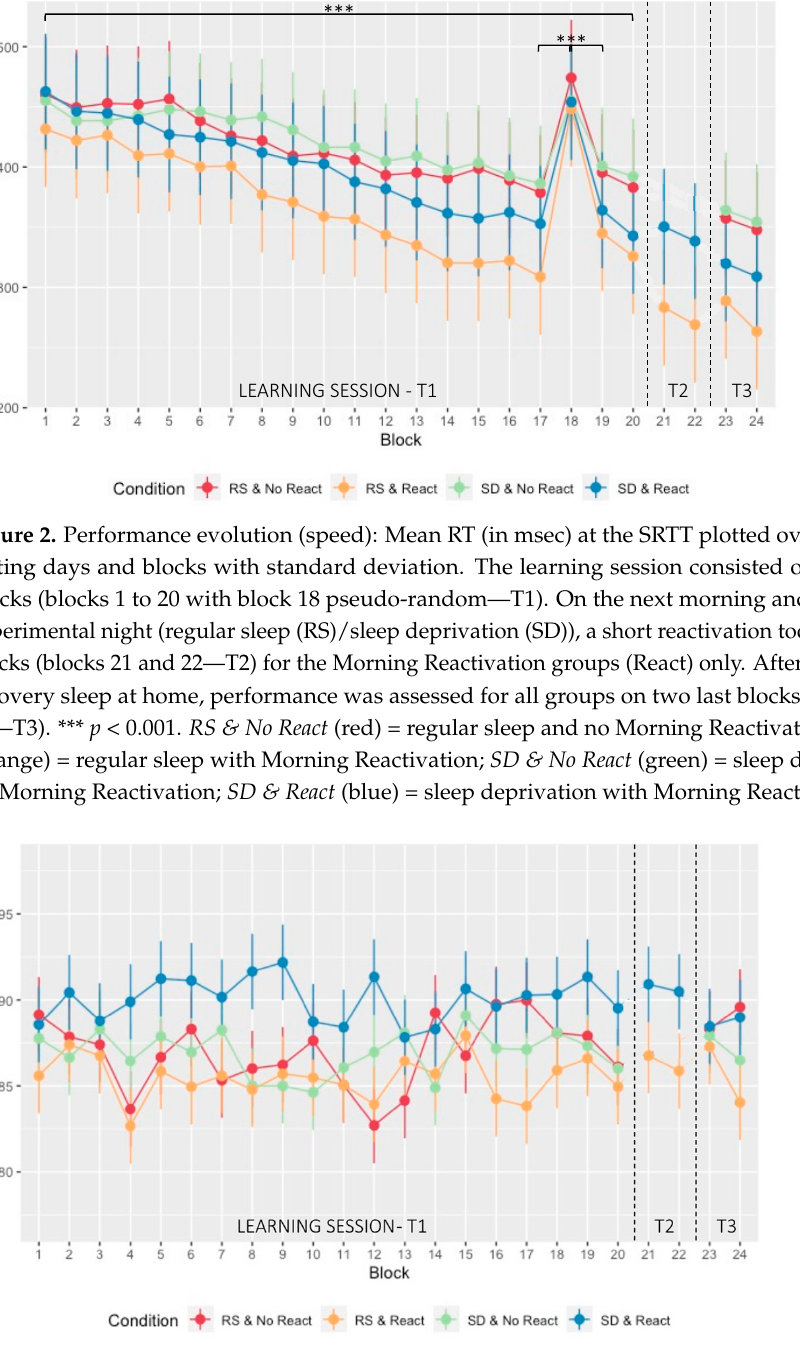
Figure 3. Performance evolution (accuracy): Percentage of correct triplets at the SRTT with standard deviation over the different testing days and blocks. The learning session consisted of 20 sequential blocks (blocks 1 to 20 with block 18 pseudo-random—T1). On the next morning and following the experimental night (regular sleep (RS)/ sleep deprivation (SD)), a short reactivation took place on two blocks (blocks 21 and 22—T2) for the two Morning Reactivation groups (React) only. After three nights of recovery sleep at home, performance was assessed for all participants on two last blocks (blocks 23 and